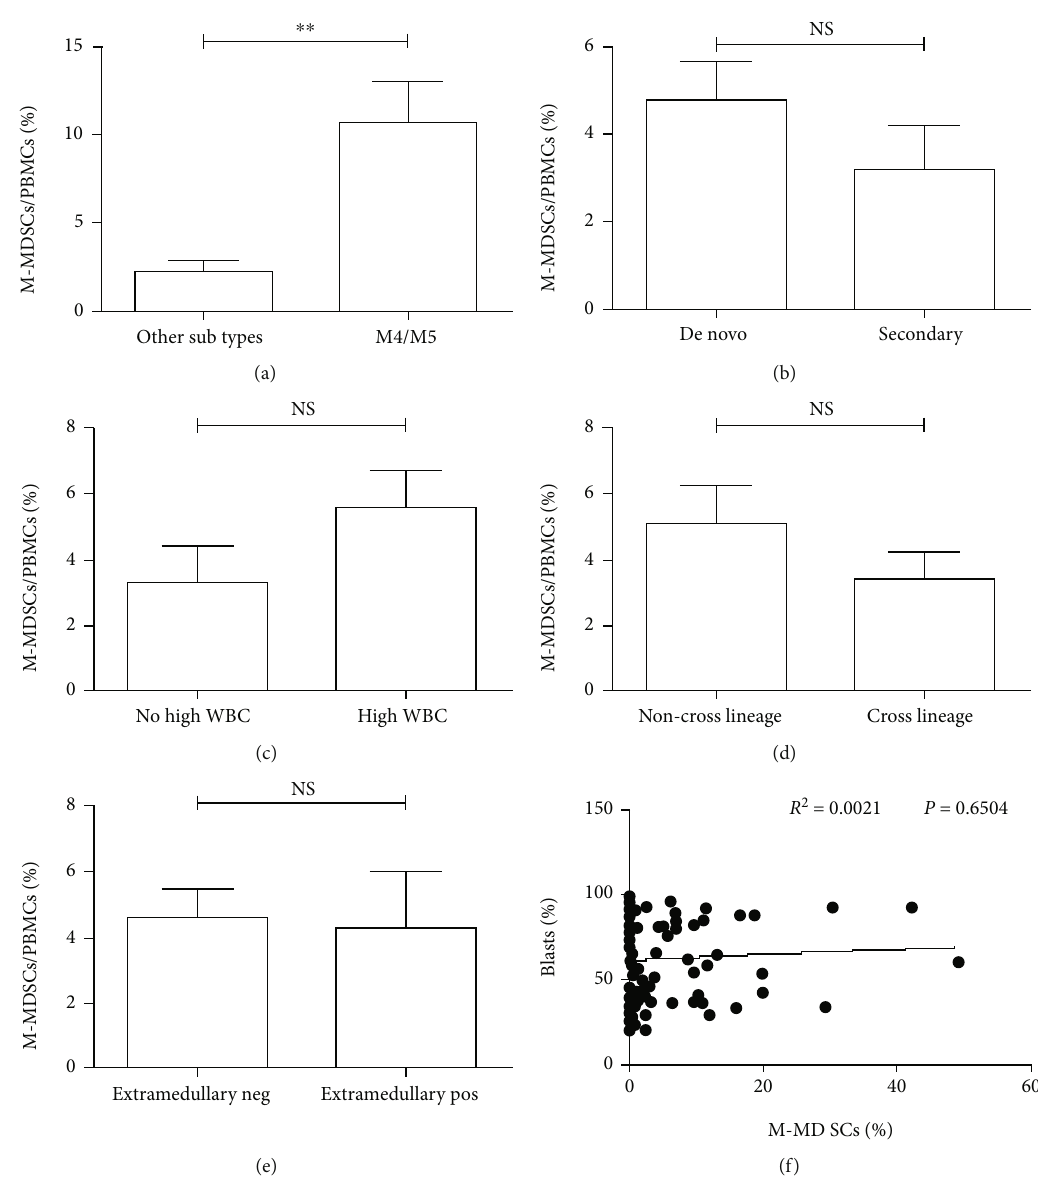
Figure 3: The correlation of circulating M-MDSC frequency and clinic risk categories in AML. The frequencies of circulating M-MDSCs in FAB M4/M5 subtype groups were signi fi cantly higher than the other FAB subtype groups (a). No signi fi cant statistical di ff erences on circulating M-MDSCs were found in the di ff erent groups of AML type, WBC count, cross linage expression, extramedullary in fi ltration, and leukemic blasts percentage (b – f). NS: not signi fi cant; ∗∗ p < 0 : 01